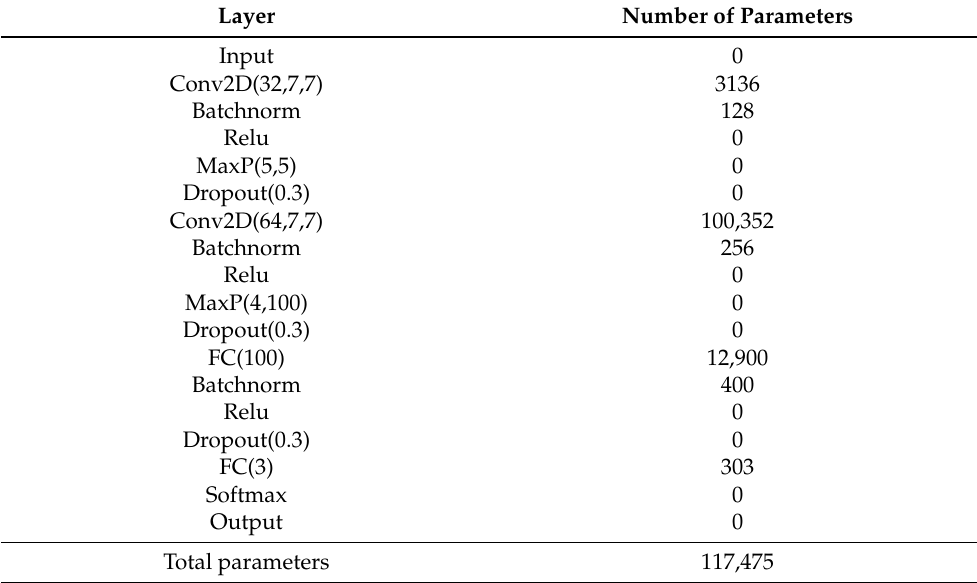
Table 1. Summary of the baseline network in terms of connection configurations and numbers of